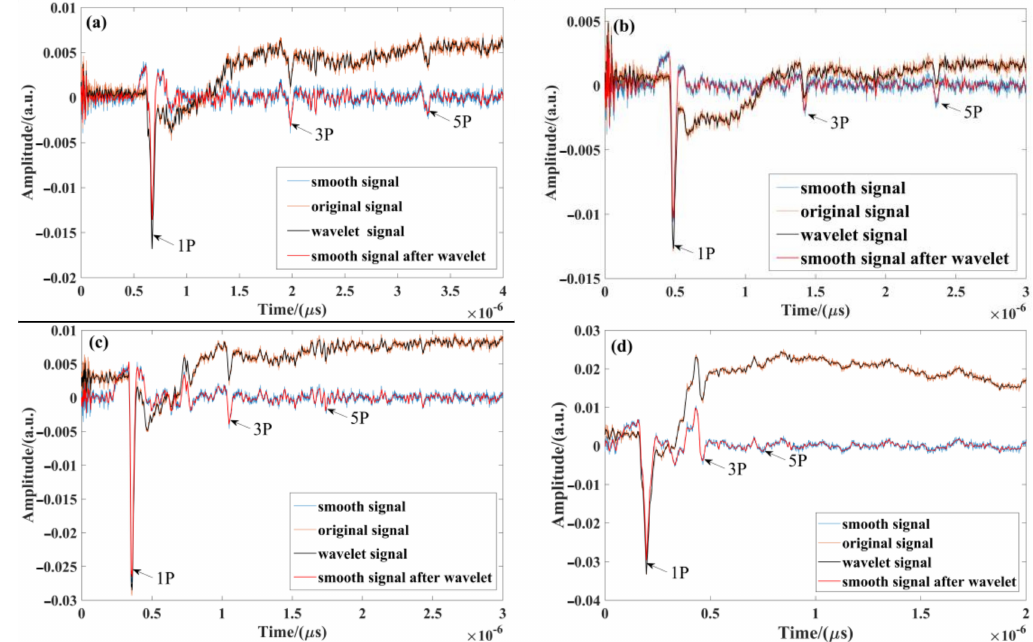
Figure 6. Ultrasonic signal of sample: ( a ) 7055-1; ( b ) 7055-2; ( c ) 7055-3; ( d )